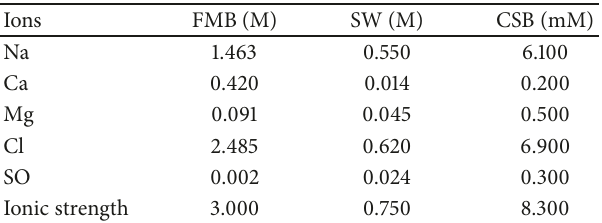
Table 1: Composition of brines electrolytes used in this work. Formation brine (FMB) represents a typical composition and ionic strength of formation brines; seawater(SW)has typical composition and ionic strength; controlled salinity brine (CSW) is 90 times diluted